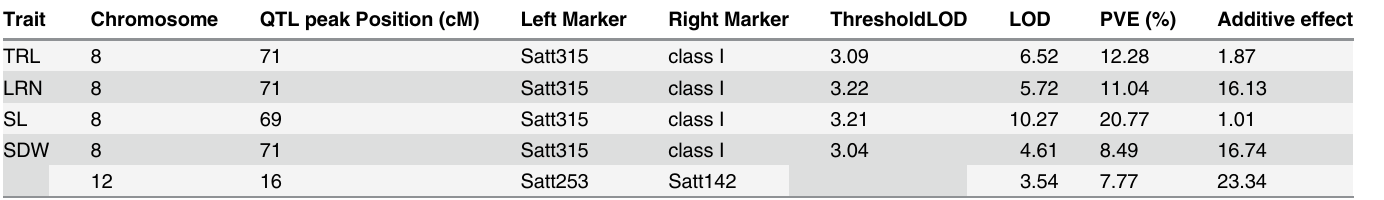
Table 3. Quantitative trait loci (QTL) for root and shoot architecture traits and their additive effects identi fi ed by inclusive composite interval mapping approach using ICI Mapping software. Trait Chromosome